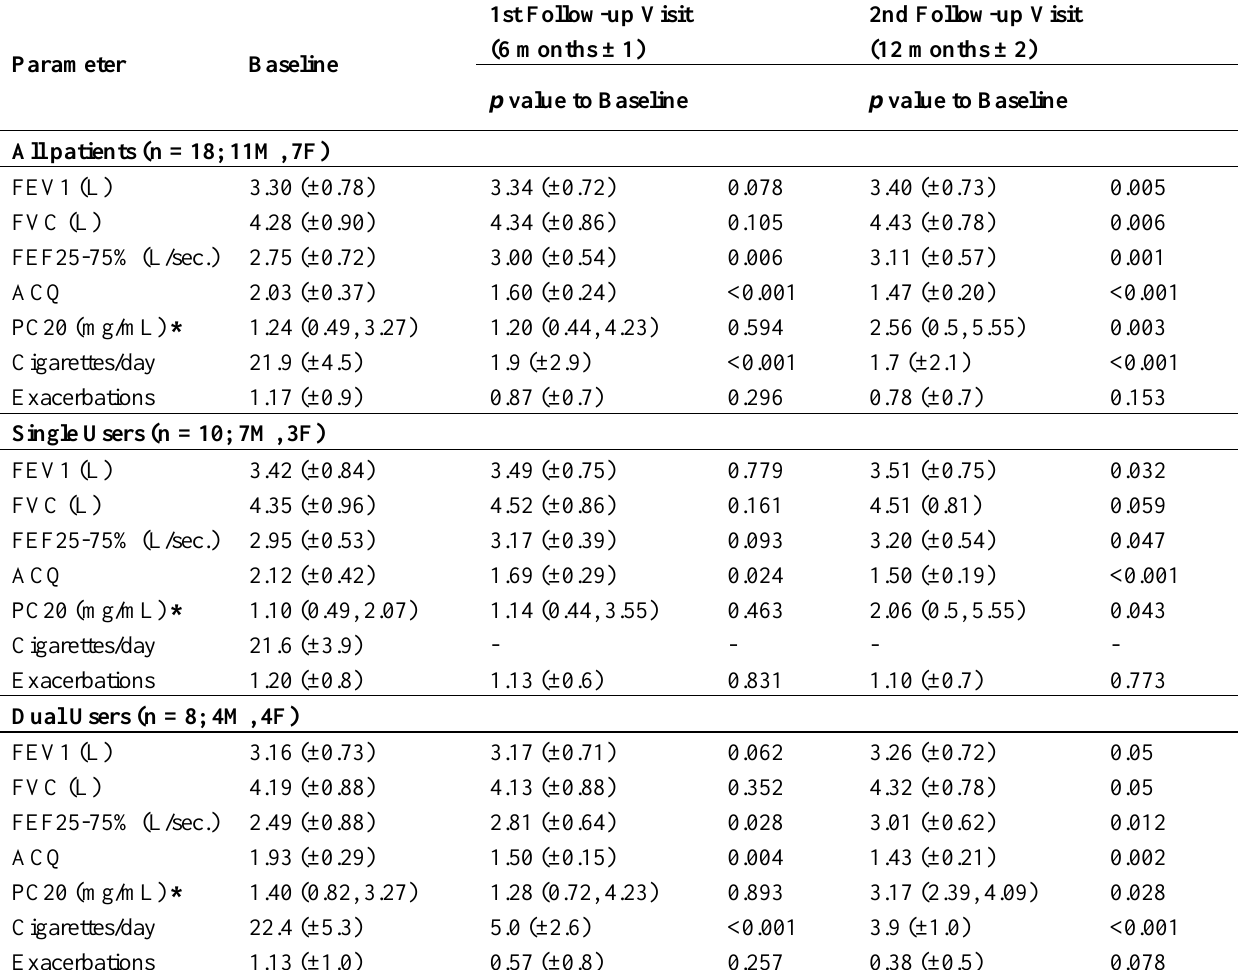
Table 2. Changes in parameters measured at baseline, 1st- and 2nd follow-up